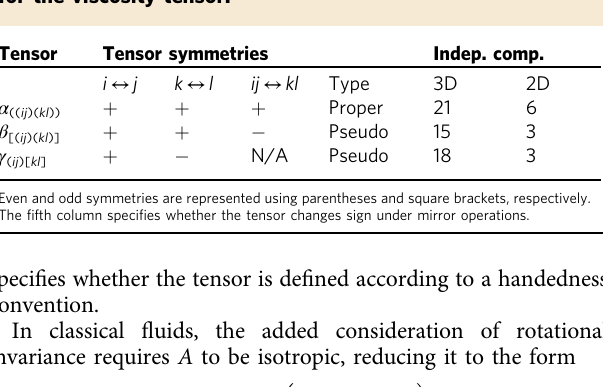
Table 1 Rank-4 tensors used as orthogonal basis elements for the viscosity